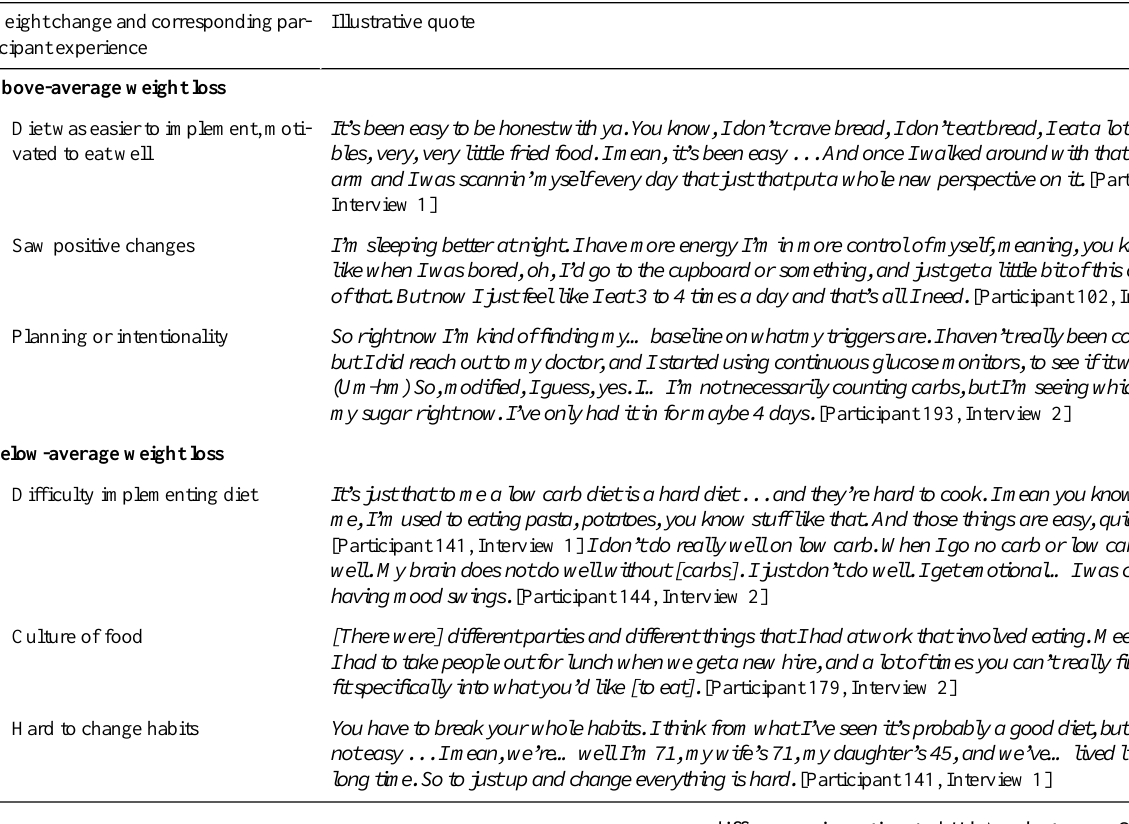
Illustrative quoteWeight change and corresponding par-